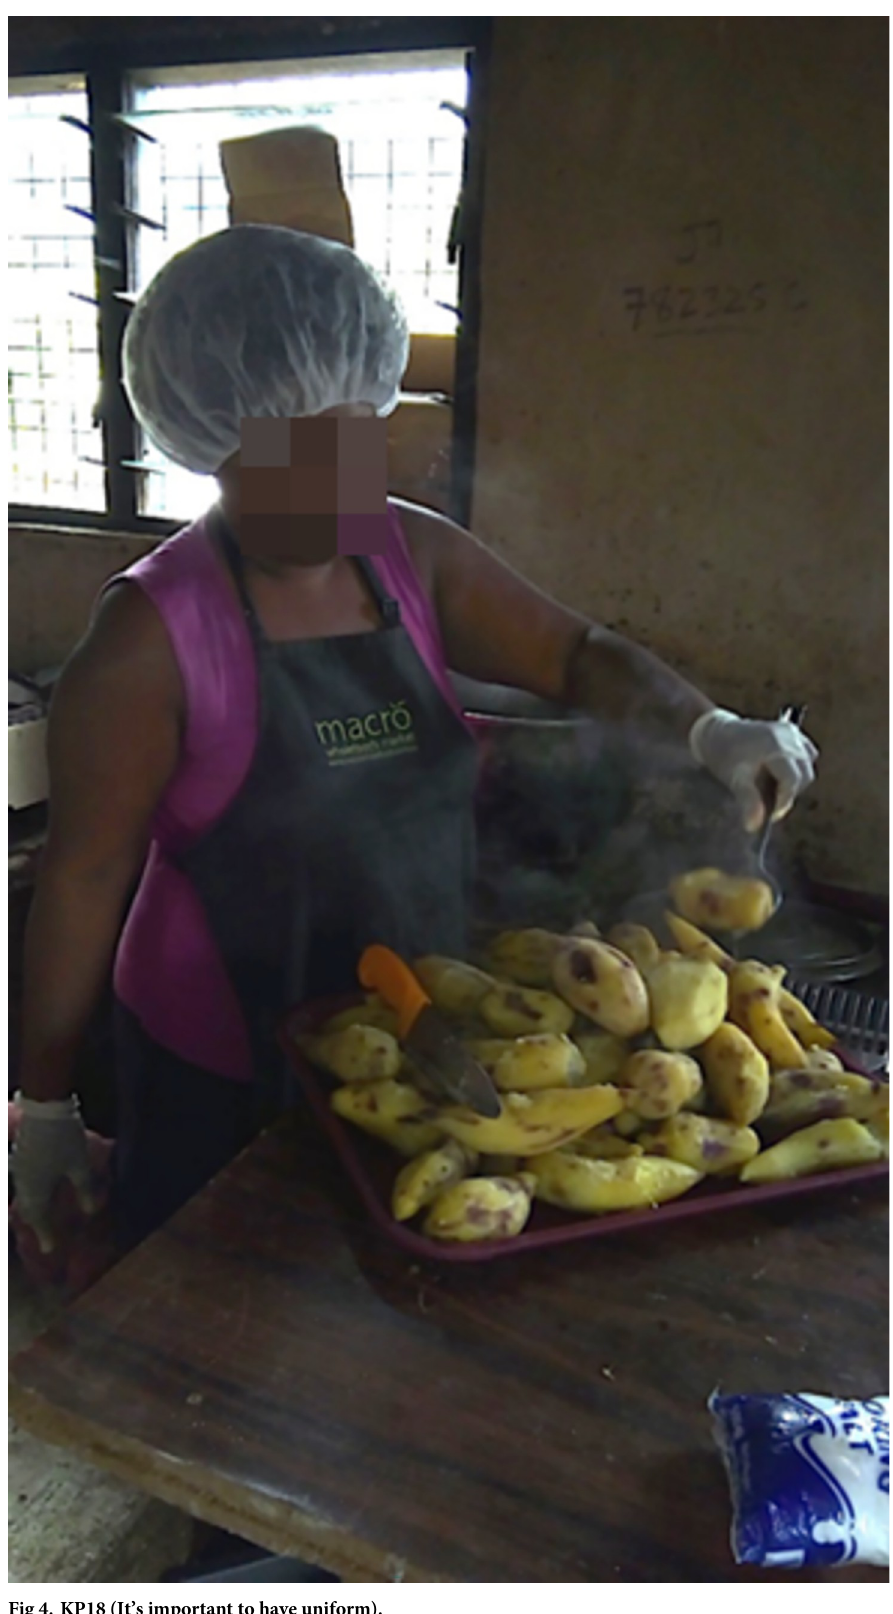
Fig 4. KP18 (It’s important to have